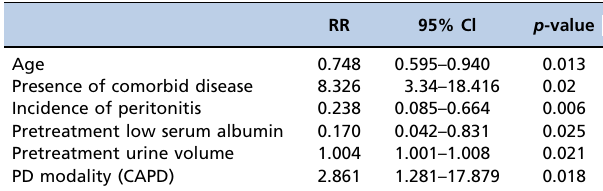
Table 4 - Multivariate Cox proportional hazards model for patient